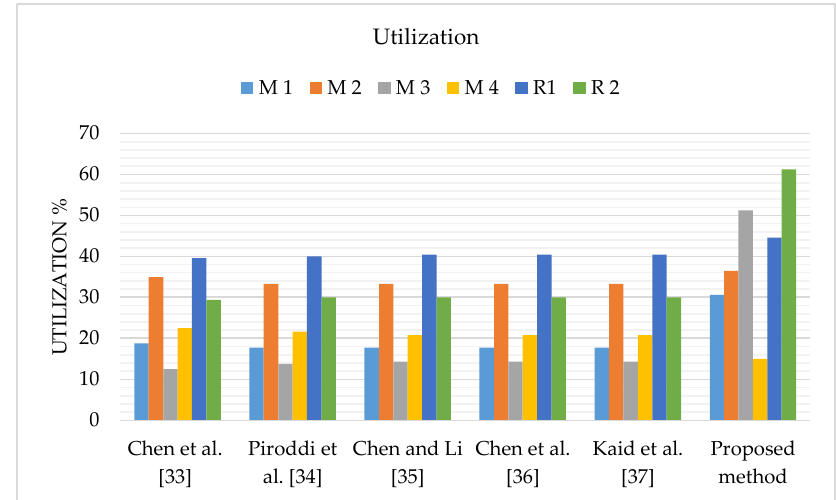
Figure 10. Comparison of utilization for the Petri net model in Figure 2.